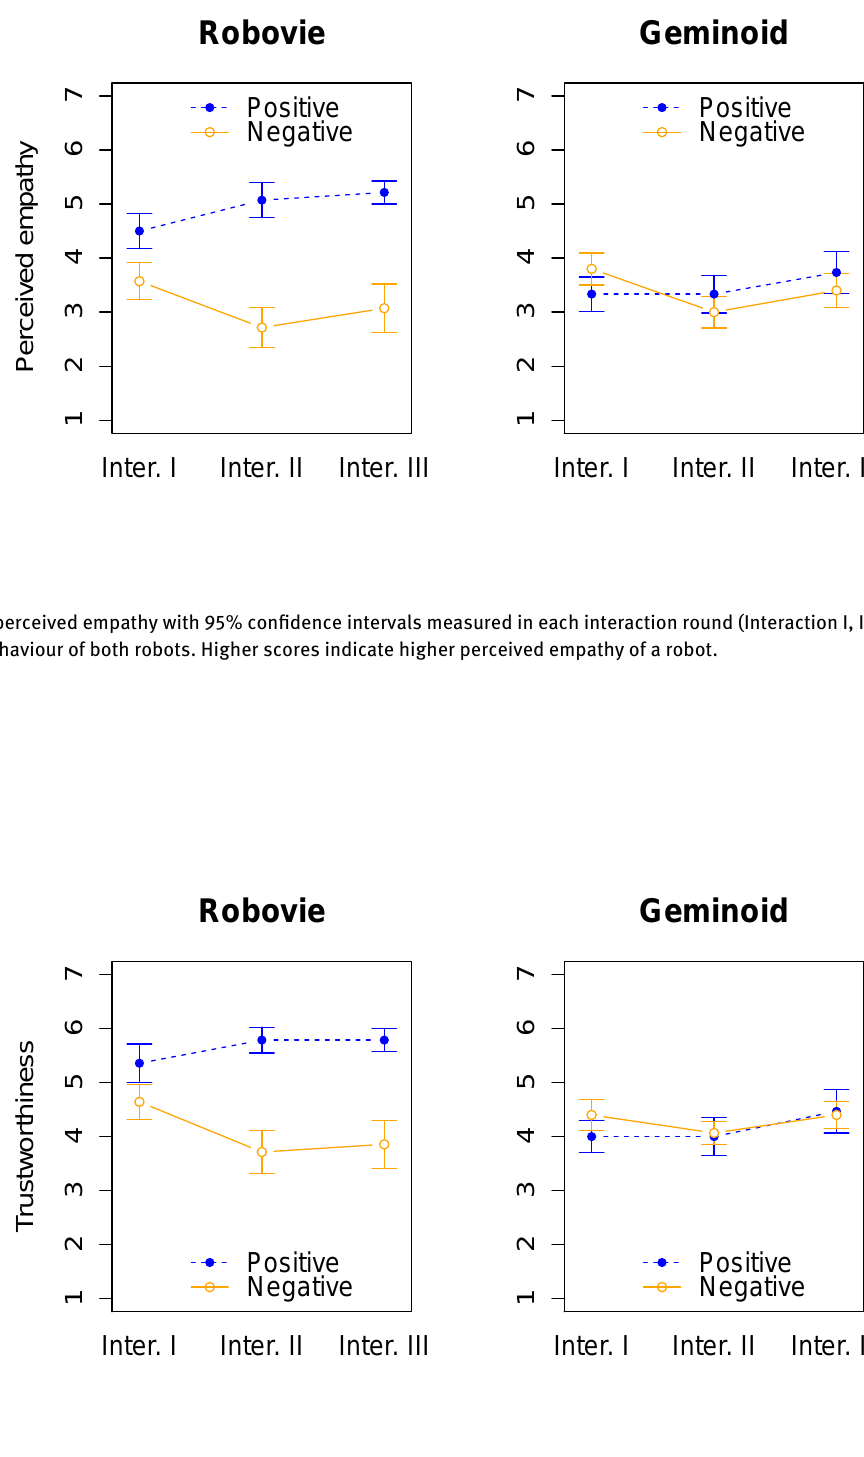
Figure 5: Mean perceived trustworthiness with 95% confidence intervals measured in each interaction round (Interaction I, II and III) for positive and negative behaviour of both robots. Higher scores indicate higher perceived trustworthiness of a